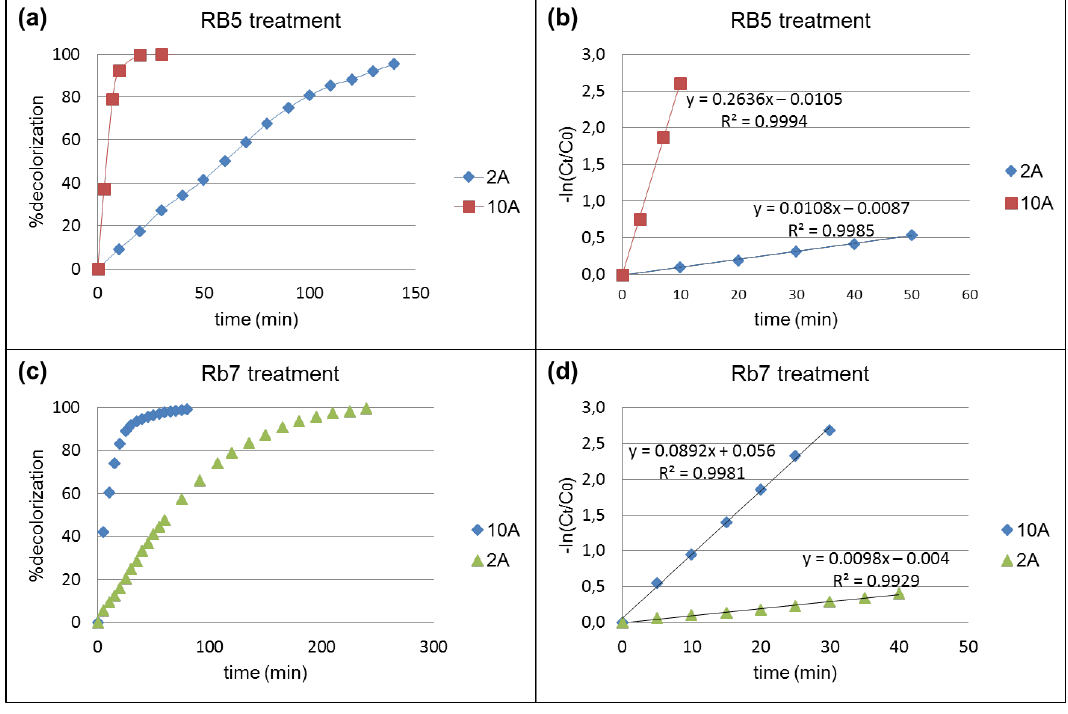
Figure 3. Evolution of dye degradation by electrochemical treatment at 2 A and 10 A. ( a ) and ( c ) % decolorization; ( b ) and ( d ) kinetic rate of decolorization. Table 2. Results of the electrochemical treatment (EC) of dyes performed at 2 A and 10 A.